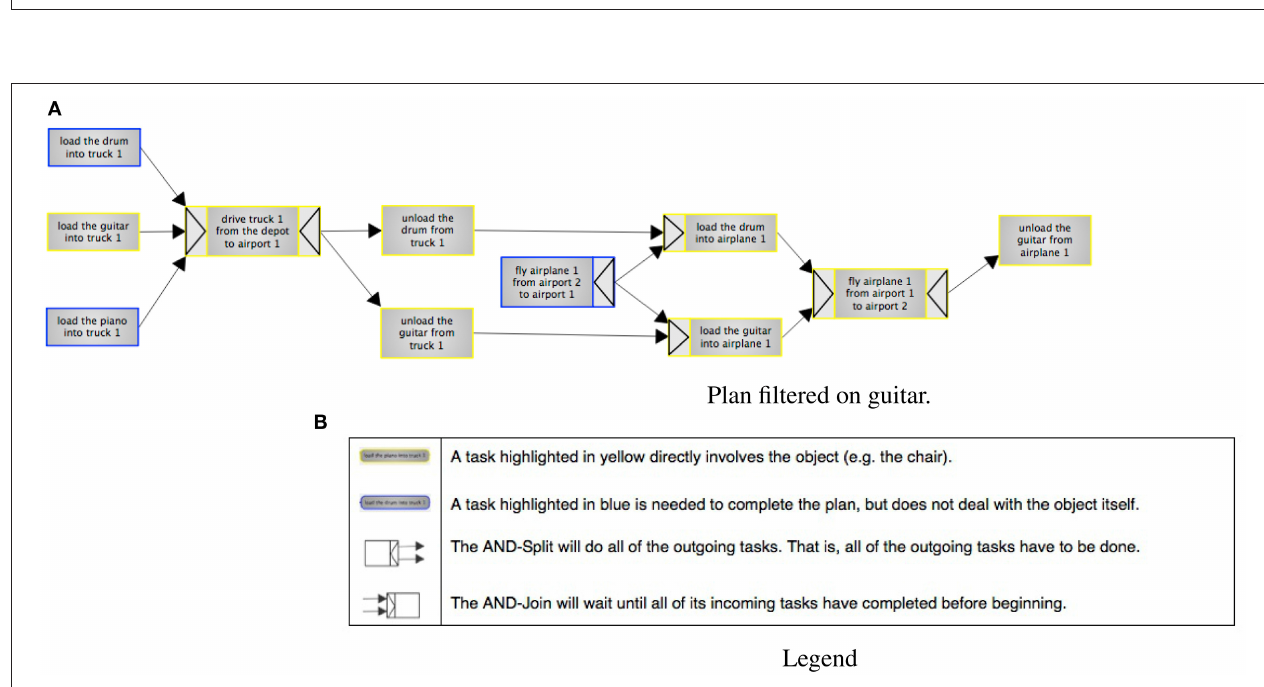
FIGURE 5 | Experiment 2, filtering on “guitar.” Steps with a blue border involve the guitar directly, whereas steps with yellow borders are dependencies. The legend explains color coding, splits and joins. (A) Plan filtered on guitar. (B) Legend.